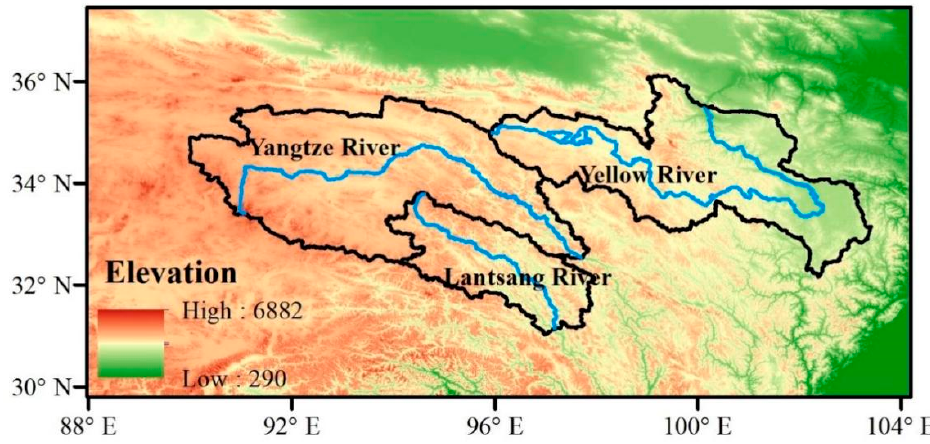
Figure 1. The overview of the Source Region of Three Rivers.